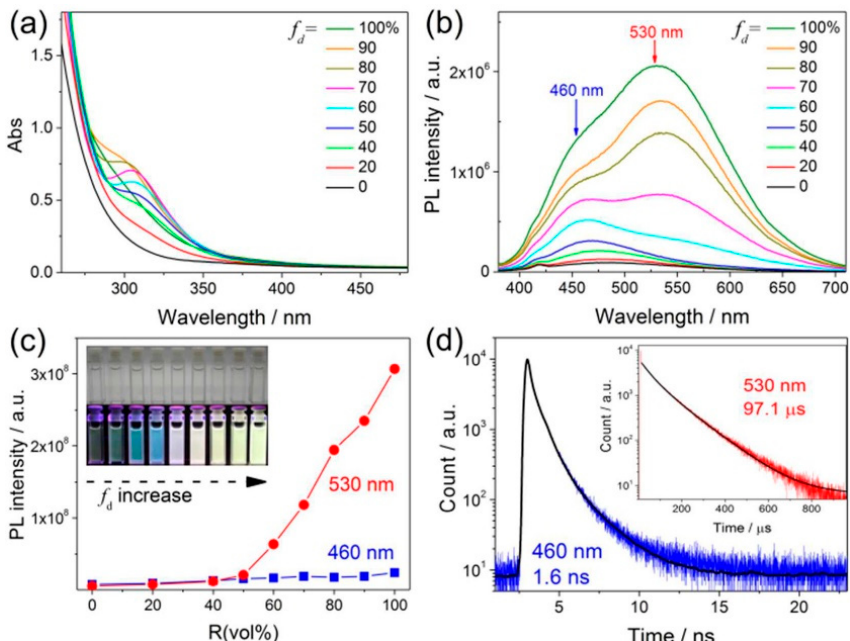
Figure 13. ( a ) UV − vis absorption and ( b ) photoluminescence spectra of polymethyl vinyl ether-alt-maleic acid-capped silver nanoclusters (PMVEM-Ag NCs) in the varied volume fraction f d of DMSO in the mixed solvent ( f d = V DMSO /V DMSO+water ). Photoluminescence was excited at 365 nm. ( c ) Correlations of the emission intensities of the two peaks centered at approximately 460 and approximately 530 nm versus f d . (Inset) Photographs of PMVEM-Ag NCs at different f d under visible (top row) and UV (bottom row) light. ( d ) Time-resolved luminescence decay profiles of PMVEM-Ag NCs in DMSO measured at 460 and 530 nm (inset), respectively. Reprinted with permission from Ref. [88]. Copyright (2017) American Chemical Society.